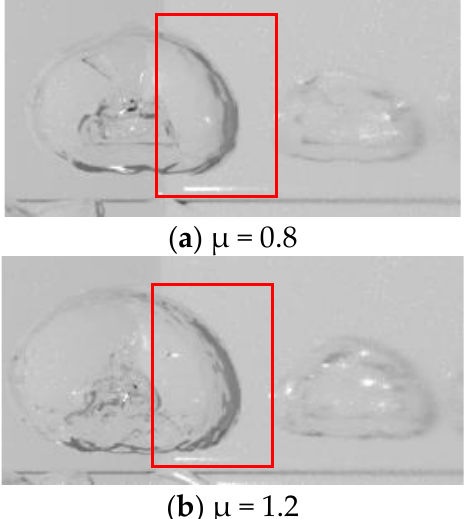
Figure 10. Comparison of different viscosity coefficients.